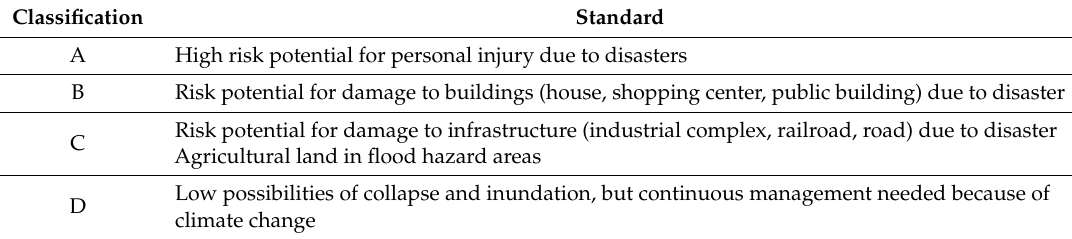
Table 3. Classification standard (National Emergency Management Agency (NEMA),